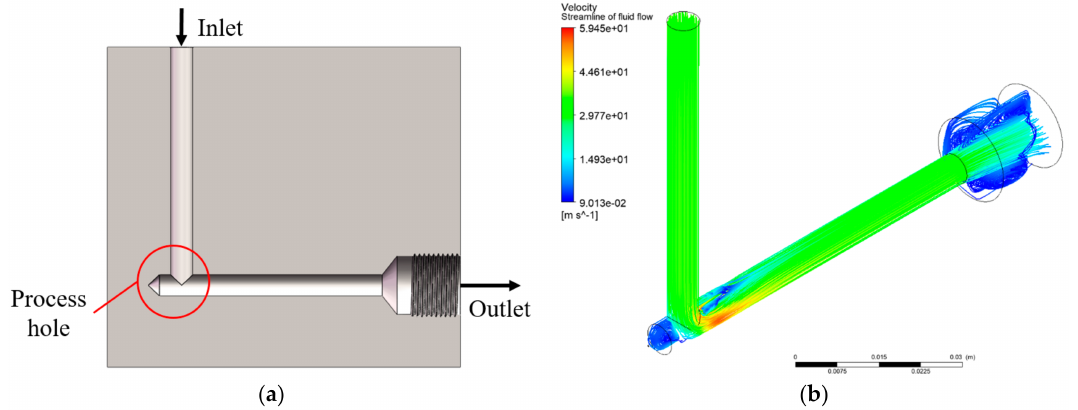
Figure 7. A hydraulic manifold with one flow channel: ( a ) cross-section view of the CAD model, ( b ) streamlines visualized by CFD-Post (Re = 5156 and Ma = 0.019 at the bent 45 ◦ cross